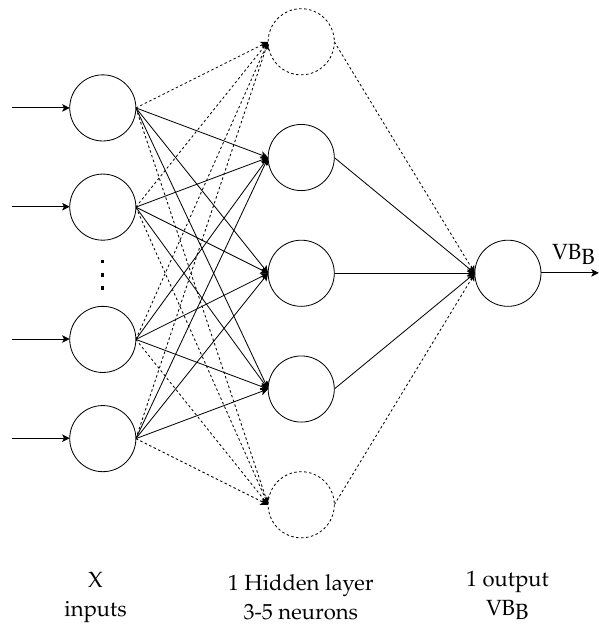
Figure 8. General form of an ANN used for tool condition